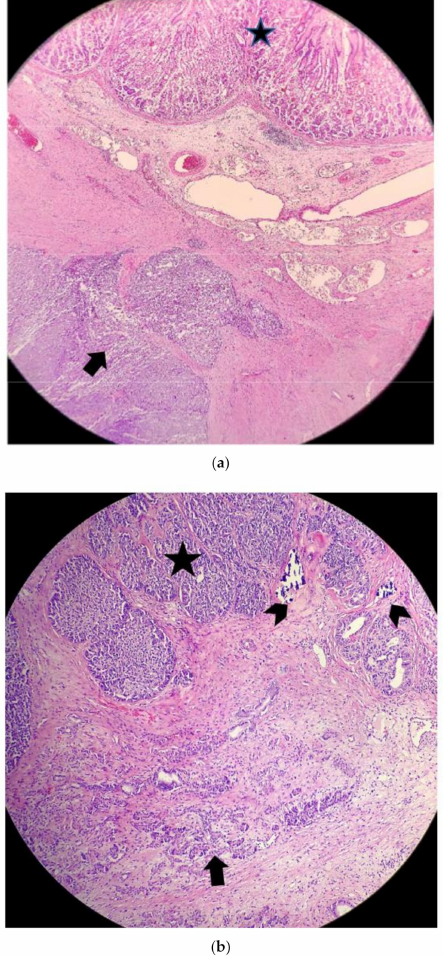
Figure 9. ( a ) Above, gastric mucosa (star); below, gastric wall with neoplastic infiltration (arrow) (H&E, 100 × ). ( b ) The lesion (star) infiltrating the pancreatic parenchyma (arrow) which shows moderate atrophy. Occasional calcifications are also present (small arrows) (H&E 100 × ).